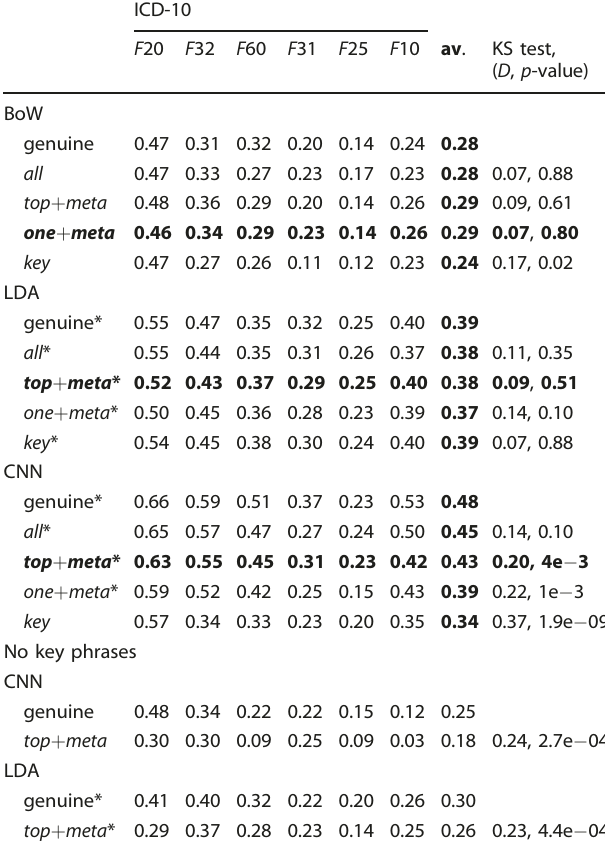
Table 7. Text classi fi cation results ( F 1-scores) for test-class-mhr ( fi vefold CV; results averaged per class). We use 2S-KS test for (a) comparisons between models trained with the same type of data; * marks statistically signi fi cant improvements for LDA over BoW, and CNN over LDA ( α = 0.05, n 1 = n 2 = 30); (b) comparisons within a model trained with the different types of data (column KS test). Models using less than all key phrases that provided results closest to those with real data are highlighted in bold. We also report results of our ablation experiments when the training data contain only the context of key phrases, real, or generated.